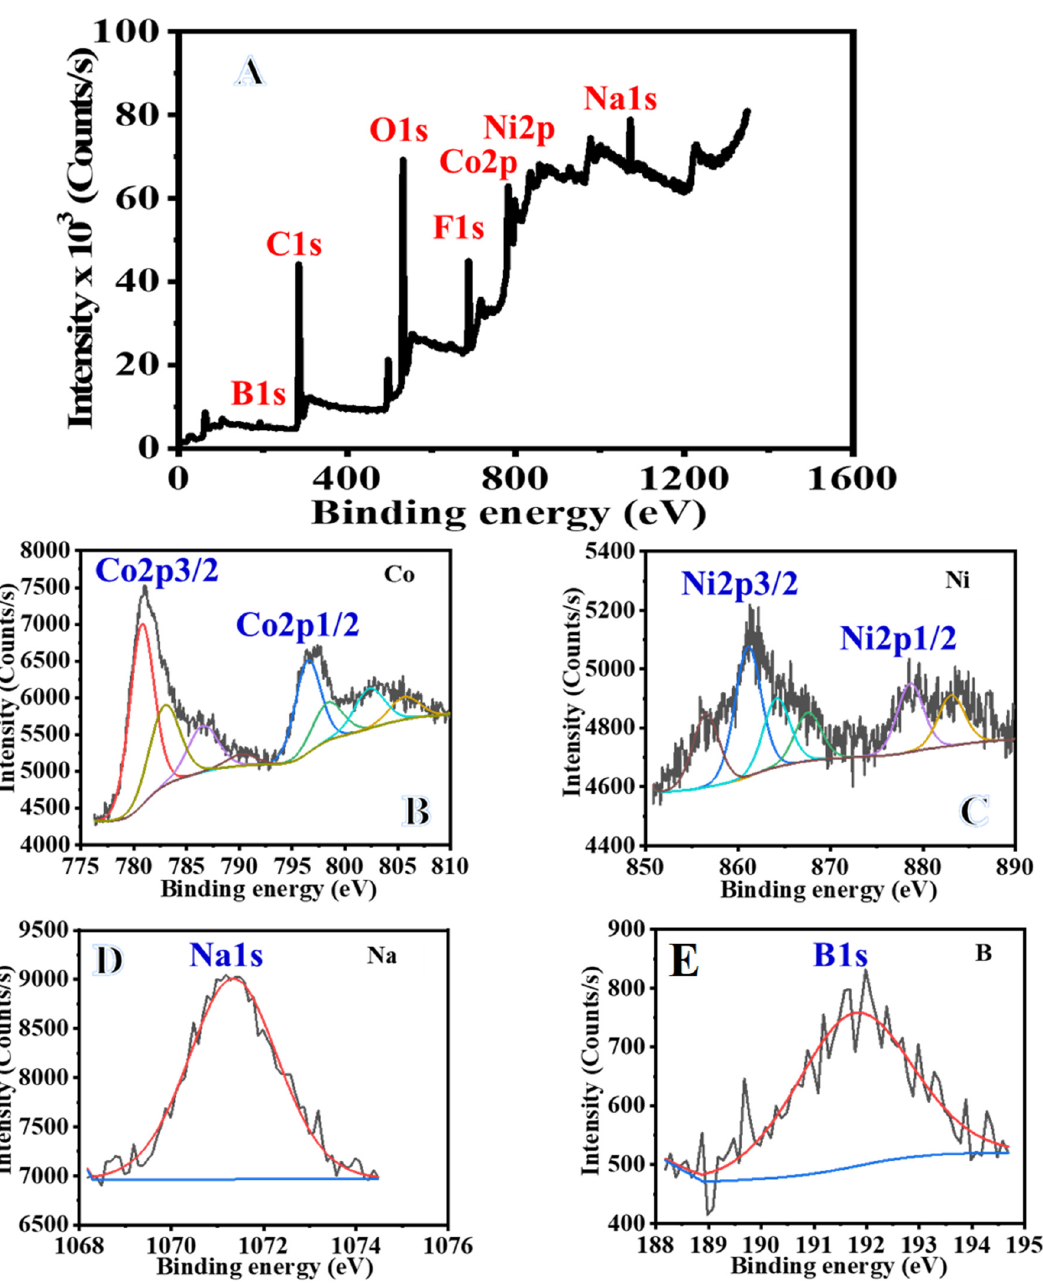
Figure 11. XPS spectra of the Ni 0.3 Co 0.7 @PVDF-co-HFP NF membrane after ten reused cycles: full spectrum ( A ), Ni2p ( B ), Co2p ( C ), Na1s ( D ), and B1s ( E ).